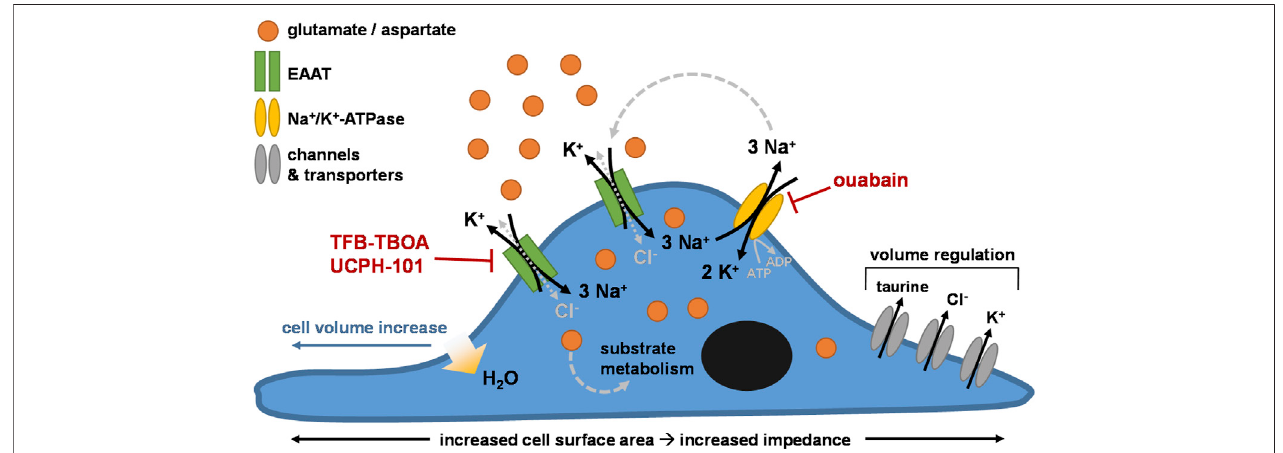
FIGURE 7 | Proposed mechanism of the phenotypic impedance-based assay. Cells (over)expressing excitatory amino acid transporters (e.g., EAAT1) are stimulatedwith exogenous substrate (e.g., glutamate). Thesubstrate istakenup intothecell through EAAT togetherwith3Na + inexchangefor1K + . Cl − entersthe cells via uncoupled Cl − -conductivity of EAAT or other Cl − in fl ux mechanisms, counterbalancing the increase in intracellular Na + . The Na + /K + -ATPase (NKA) restores the transmembrane Na + gradient byATP-dependentef fl uxof3Na + inexchange for2K + .Over time,theintracellular concentrationsofsubstrate, Na + ,K + ,andCl − ions initially rise, increasing cell osmolarity. Subsequent cell swelling, via in fl ux of H 2 O into the cytosol, triggers cell spreading, which increases the surface area of the E-plate thatiscovered bycells.Regulatorymechanismsleadtodissipation ofthehigh intracellular ionconcentrations via channels and/or transporters thatmediate ef fl ux ofCl − , K + , and osmolytes such as taurine, effectively reducing cell volume over